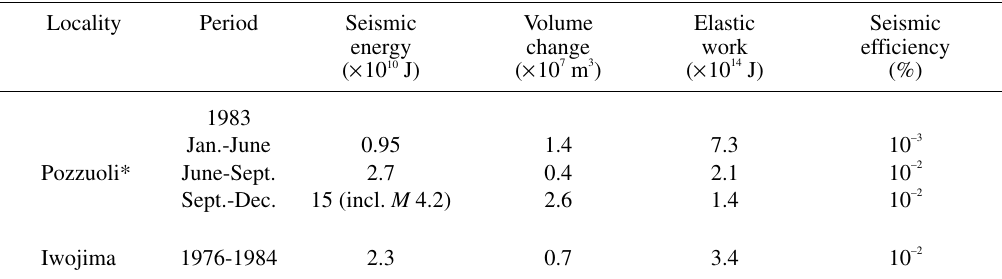
Table I. Seismic efficiencies of the activities of Pozzuoli and